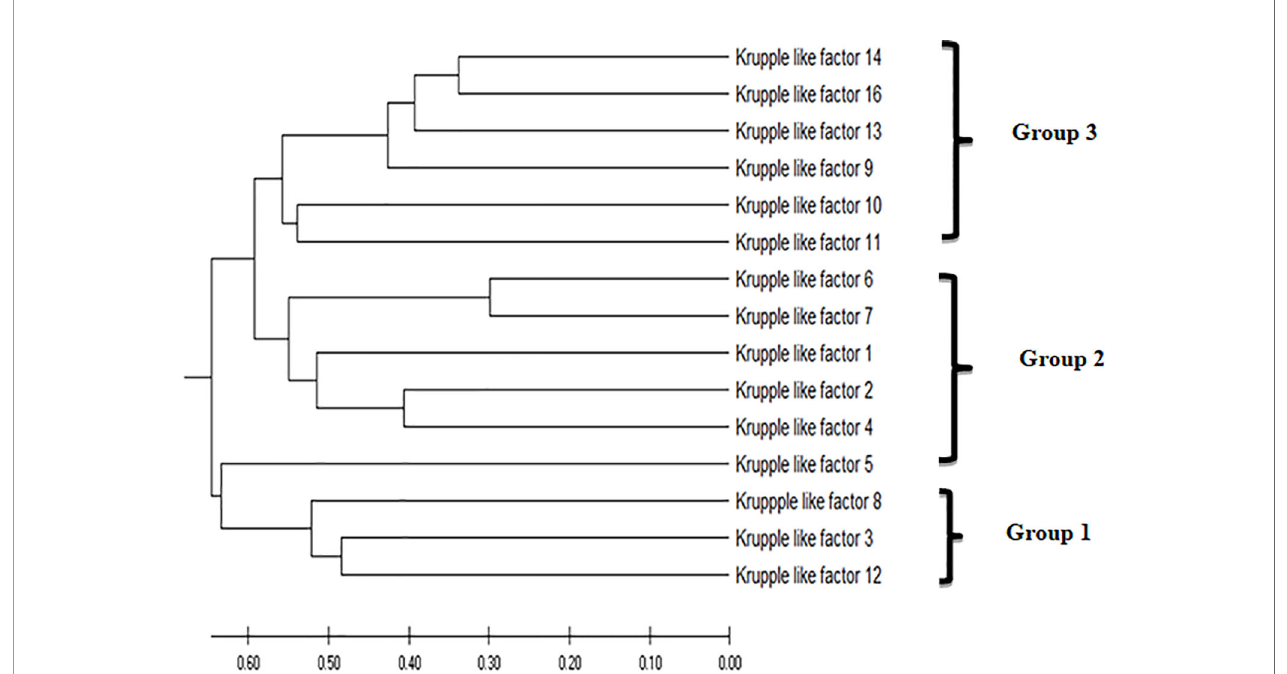
FIGURE 2 | The evolutionary history was inferred using the unweighted pair group method with arithmetic mean (UPGMA). The optimal tree with the sum of branch length = 7.54632578 is shown. The tree is drawn to scale, with branch lengths in the same units as those of the evolutionary distances used to infer the phylogenetic tree. The evolutionary distances were computed using the Poisson correction method (39) and are in the units of the number of amino acid substitutions per site. This analysis involved 15 amino acid sequences. All ambiguous positions were removed for each sequence pair (pairwise deletion option). There were a total of 602 positions in the fi nal dataset. Evolutionary analyses were conducted in MEGA X